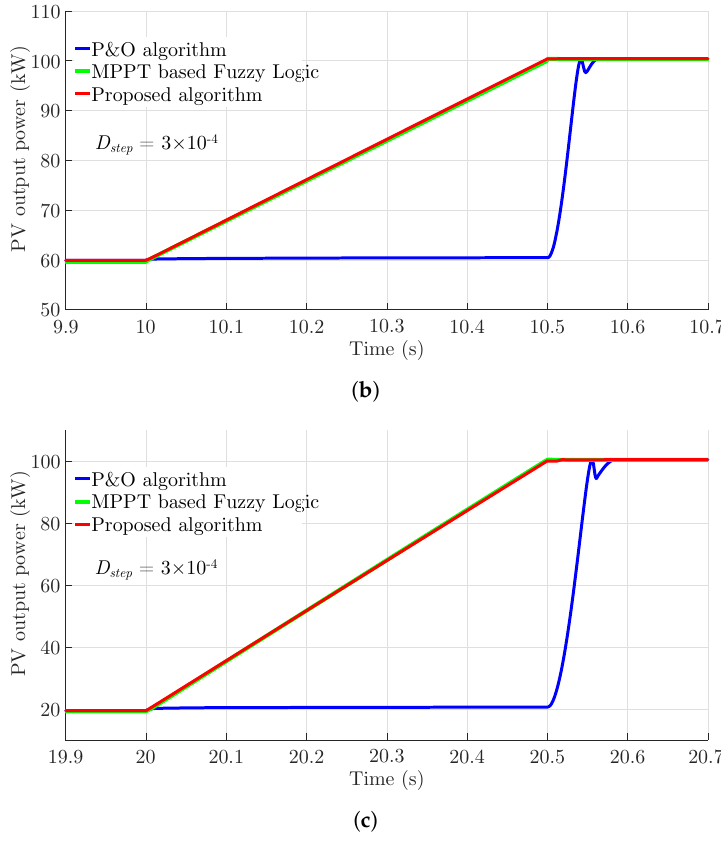
Figure 16. Comparison of the output power in the case of solar radiance increasing rapidly within 0.5 s periods and with D step = 3 × 10 − 4 : ( a ) solar radiance increase from 200 W/m 2 to 600 W/m 2 ; ( b ) solar radiance increase from 600 W/m 2 to 1000 W/m 2 ; ( c ) solar radiance increase from 200 W/m 2 to 1000 W/m 2 .